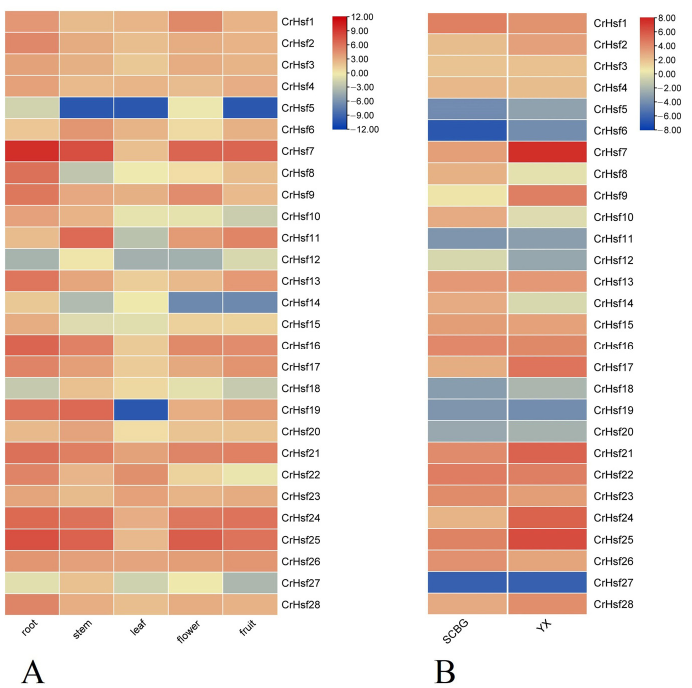
Figure 6. Heatmaps showing: ( A ) The expression levels of the 28 CrHsf genes in the root, stem, leaf, flower bud, and young fruit of C. rosea plant; ( B ) expression differences of the 28 CrHsf genes in mature C. rosea leaves captured from adult plants growing in the South China Botanical Garden (SCBG) and on Yongxing Island (YX). The expression level of each gene is shown in FPKM values (log2). Orange red denotes high expression levels, and dark blue denotes low expression levels.